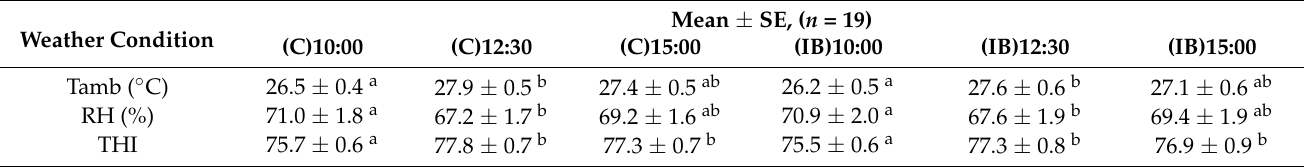
Table 1. Mean ± SE of ambient temperature (Tamb), relative humidity (RH), and temperature– humidity index (THI).